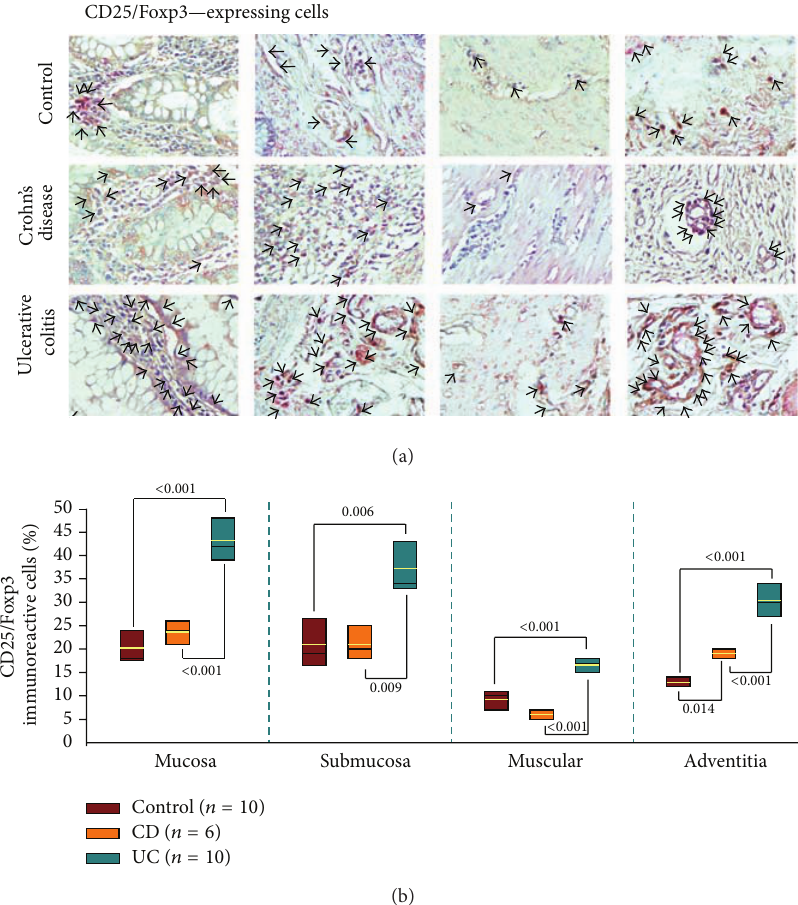
Figure 8: CD25 + /Foxp3 + cells in colonic mucosa from IBD (UC and CD) patients. (a) Representative immunoperoxidase of CD25/Foxp3 expression in non-inflamed colonic tissue (upper panel), in tissue from an active CD patient (middle panel), and in colonic mucosa from an active UC patient (lower panel). From the left to the right photomicrographs represent mucosa, submucosa, muscular, and adventitia. Arrows depict CD25 (in brown)/Foxp3 (in pink) immunoreactive positive cells (X320). (b) Bars indicate immunohistochemistry analysis of CD25 + /Foxp3 + cells in non-inflamed colonic tissues, in tissues from active CD patients, and in colonic mucosa from active UC patients. Results are expressed as median (black line), 10th, 25th, 75th, and 90th percentiles. Yellow line represents the